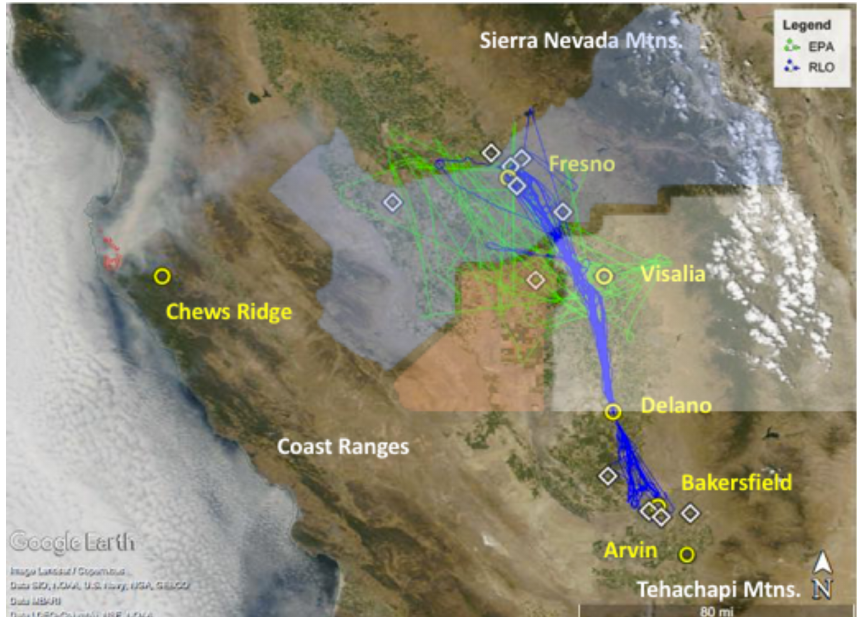
Figure 1. Satellite view of the San Joaquin Valley (© Google Earth 2019). Yellow circles are key sites. The green lines are the combined tracks from the EPA flights and the blue lines are from the RLO flights. White diamonds are CARB surface stations. Active fires on the ground can be seen as small red outlines to the northwest of the Chews Ridge site (available at: https://worldview.earthdata.nasa.gov/, Worldview, 2018) from 27 July 2016. Major mountain ranges are labeled in white. The three shaded regions are Fresno County in blue, Kings County in red, and Tulare County in